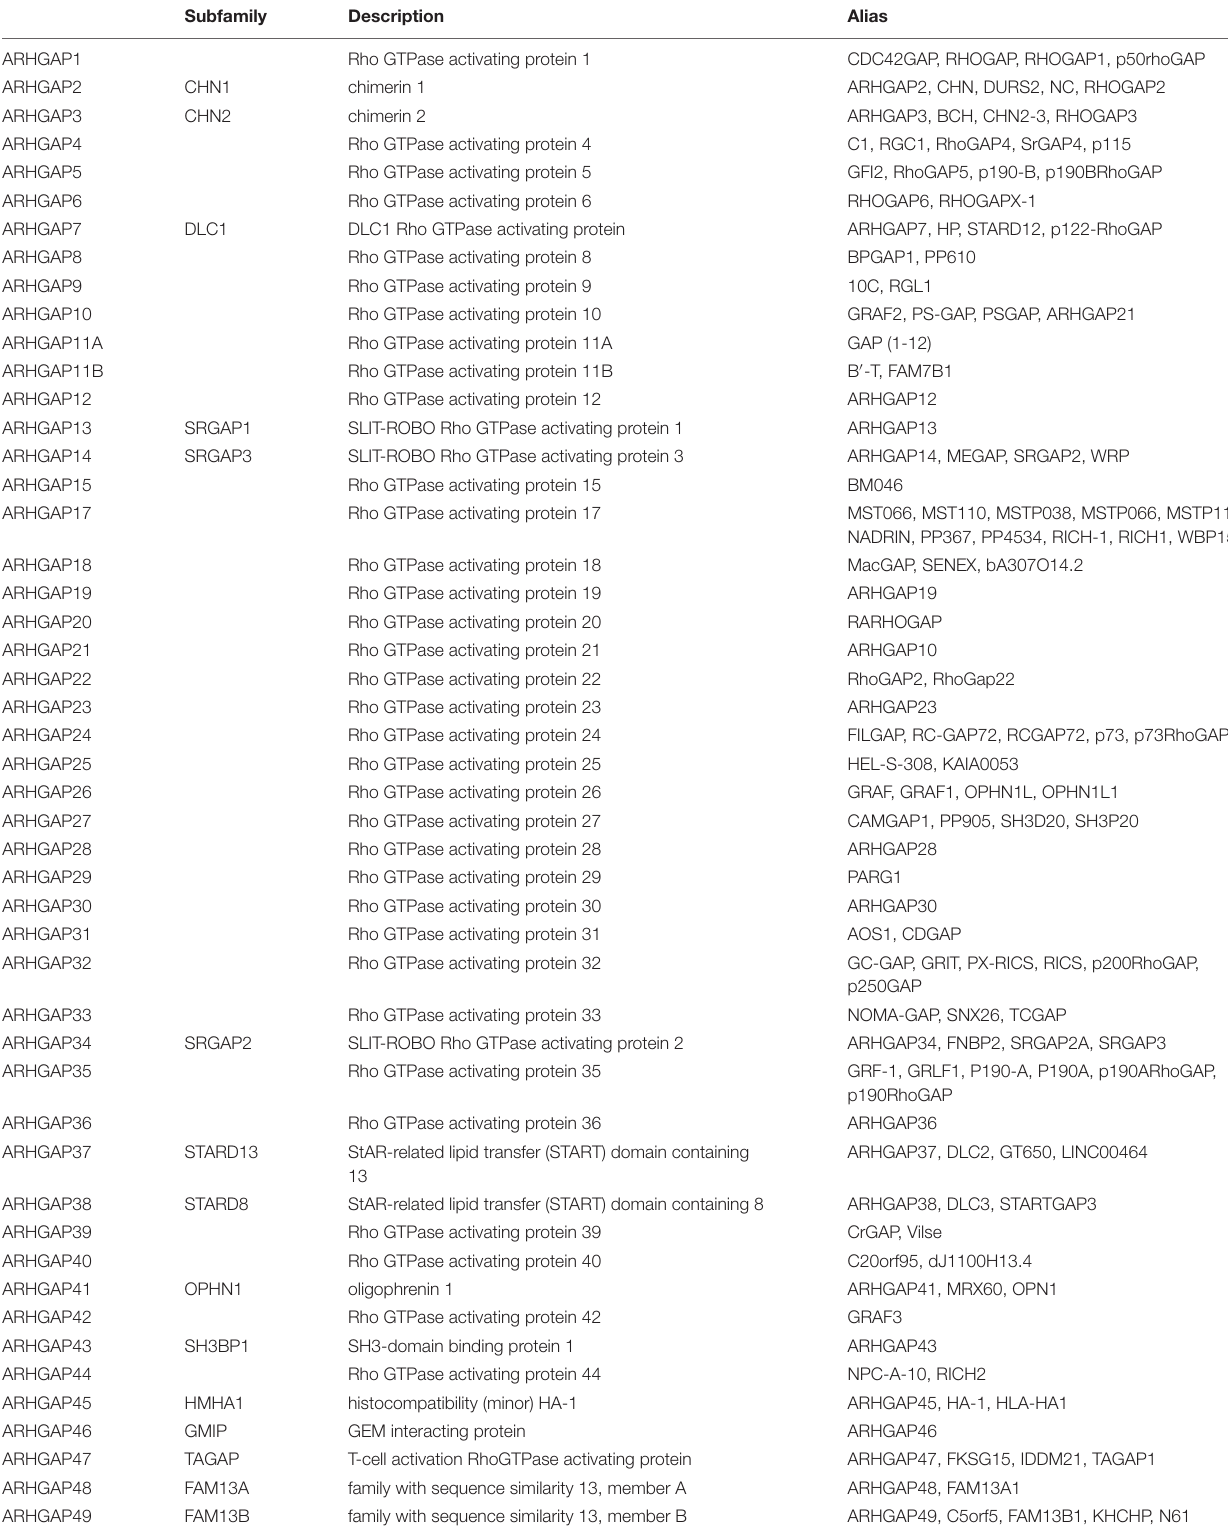
TABLE 1 | Summary of sub-family in ARHGAP family genes. Subfamily